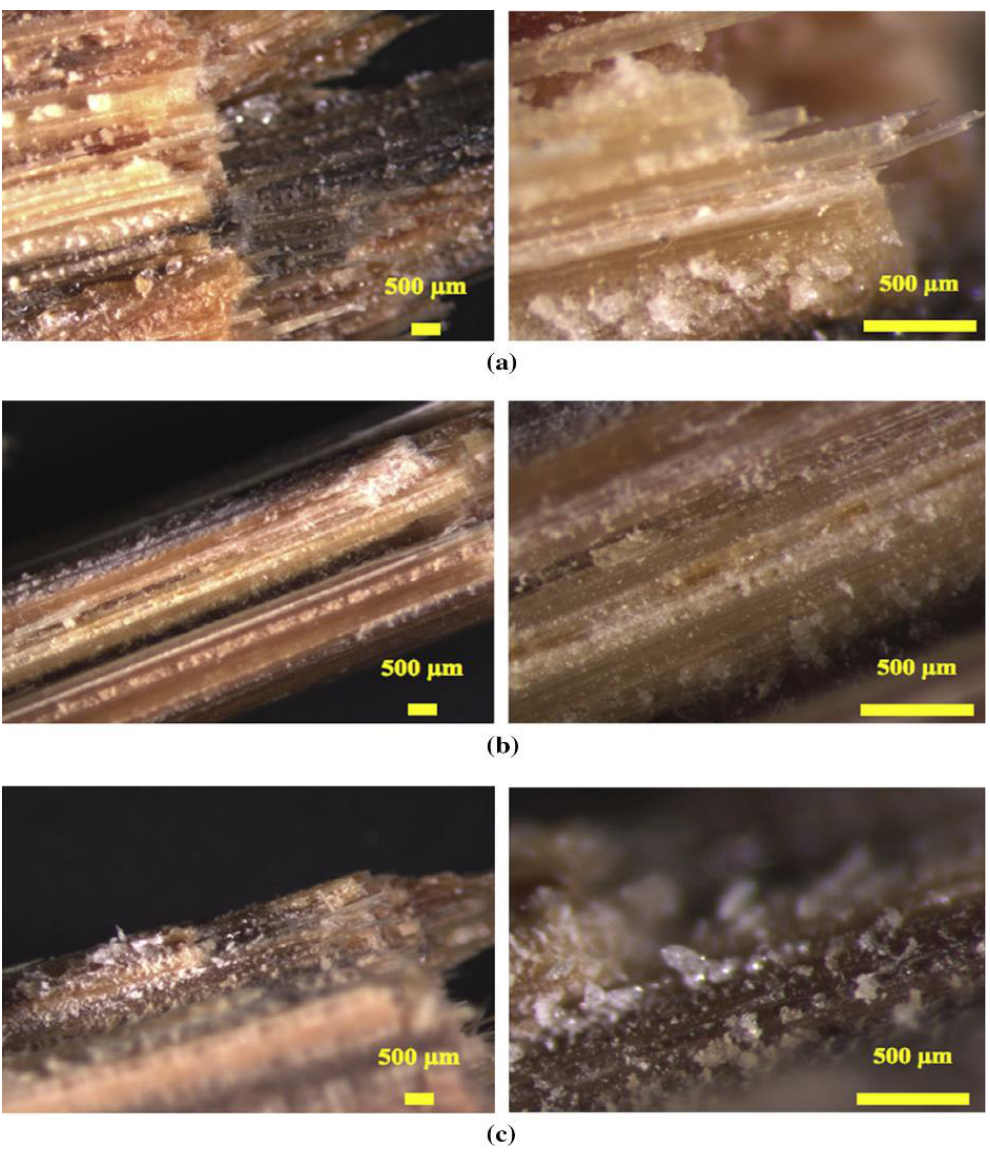
Figure 5. Optical micrographs of the fracture surface unidirectional bamboo-fibre/epoxy composite produced at 100 °C with the pressure of ( a ) 15 MPa, ( b ) 20 MPa, and ( c ) 25 MPa [54] (reprinted with permission from Elsevier, Licence Number: 5446970018062).